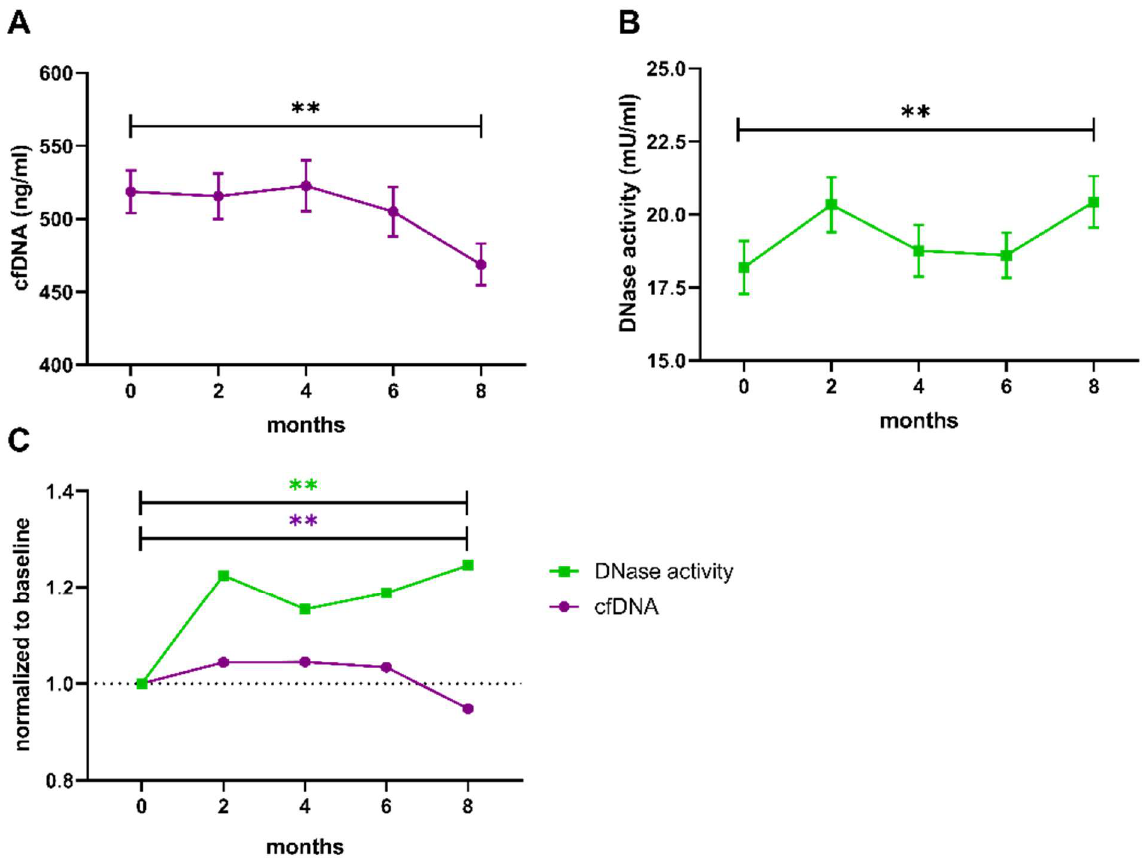
Figure 3. Trends of cfDNA levels and DNase activity during the 8-month trial period. Both parameters were measured in samples from baseline, after 2, 4, 6 and 8 months. ( A ) Levels of cfDNA and ( B ) DNase activity were compared between baseline and 8 months using a paired two-sample t-test. ( C ) Fold changes of cfDNA levels (magenta) and DNase activity (green) were calculated by normalization to the individual baseline. Data are presented as mean ± SEM. ** p < 0.01, cfDNA cell-free DNA, SEM standard error of the mean.